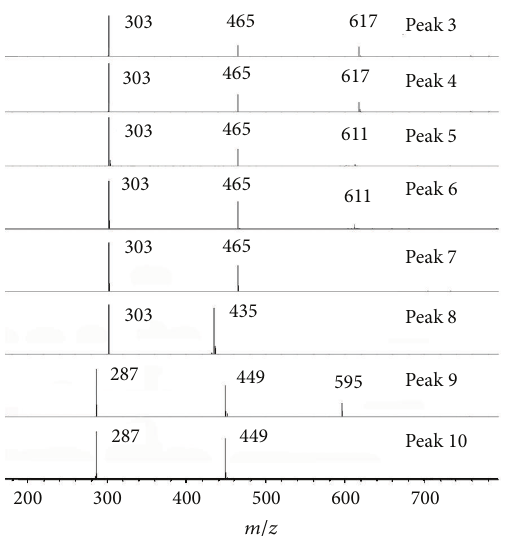
Figure 2: The mass spectra of flavonol glycosides (peak 3 to peak 10) under positive ion